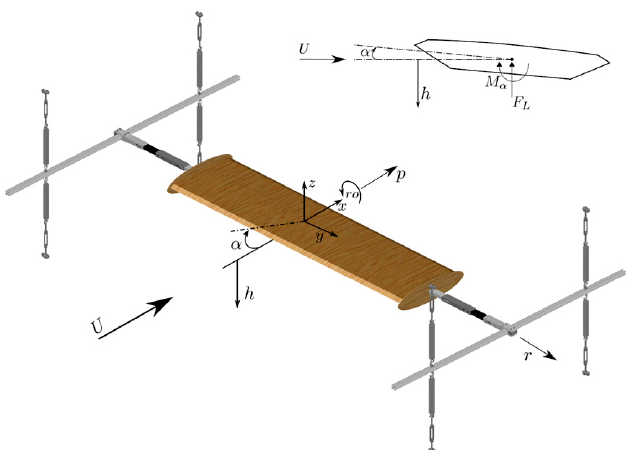
Figure 9. Possible-degree-of-freedoms of the system, where h = vertical displacement, α = rotation, p = displacement along the wind direction (restricted), r = horizontal displacement (restricted), and r o = rocking of section model (restricted).